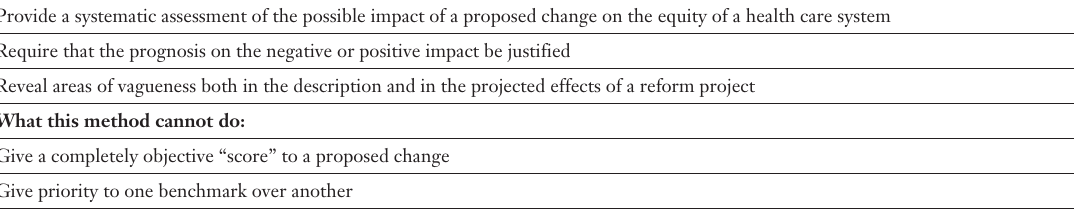
Strengths and limits of this